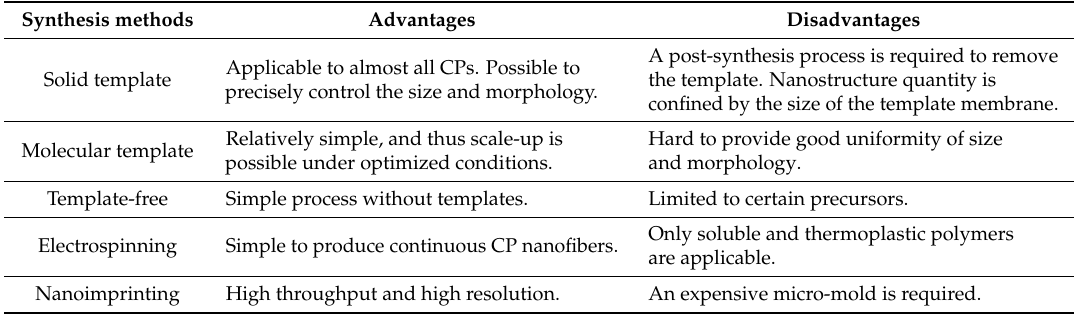
Figure 4. Schematic of the synthesis methods for CP nanomaterials. Each mechanism has been evaluated in term of variables (V), in which a low value means there are many key variables in the synthesis process; cost aspect (C), in which a low value corresponds to high cost; morphology control (M); time consumption (T); scalability (S); and purity (P) of the products. Table 2. Synthesis methods of CP